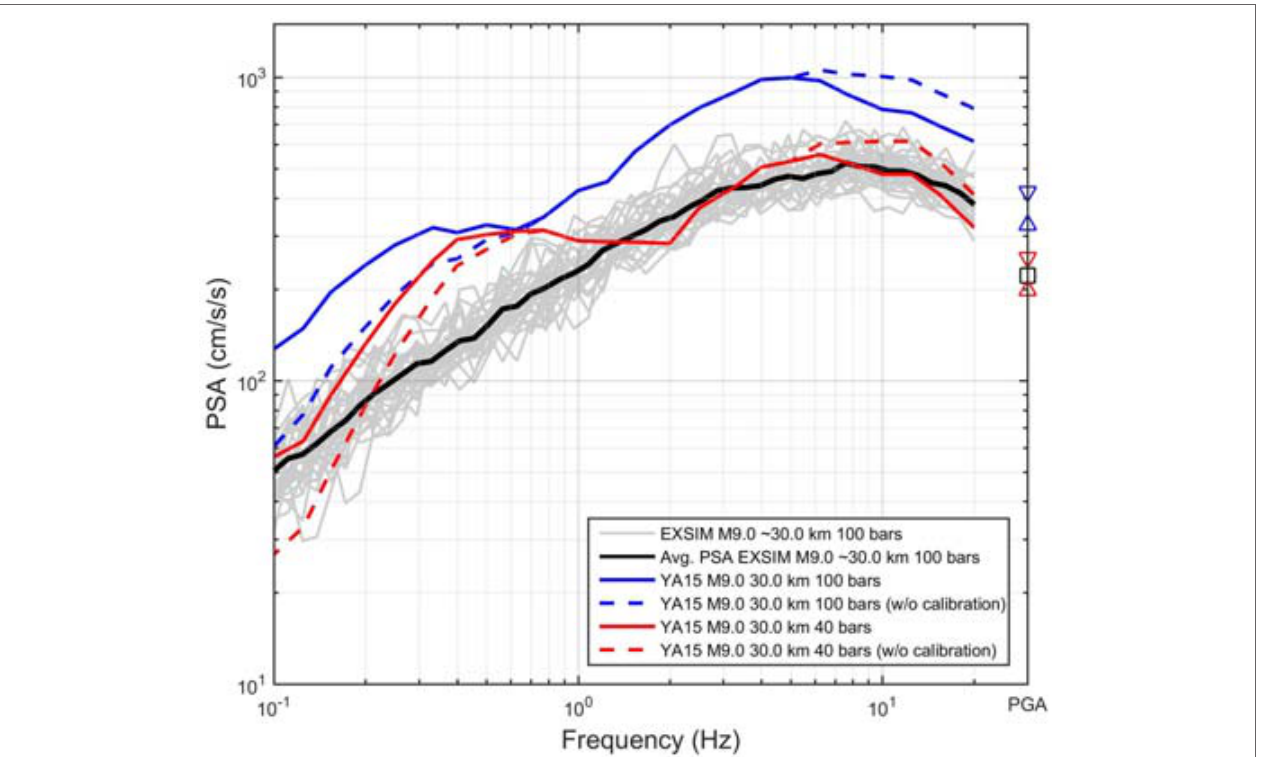
FIGURE 8 | Alternative estimates of response spectra at Rcd = 30km for an M 9.0 event. Black line is the mean of pseudospectral acceleration (PSA) for all stations at Rcd (cid:24) 30km (shown with gray lines). Solid Blue and red curves are YA15 model for stress parameter of 100 and 40bar, respectively. Dashed blue and red lines represent YA15 without considering the calibration factor. Note that YA15 is an extrapolation for M 9.0. Black square is the mean of simulated PGA for all stations at Rcd (cid:24) 30km, up and down blue triangle symbols are PGA based on YA15 models for stress parameter of 100 and 40bar, respectively, and up and down red triangle symbols are PGA based on YA15 models without considering the calibration